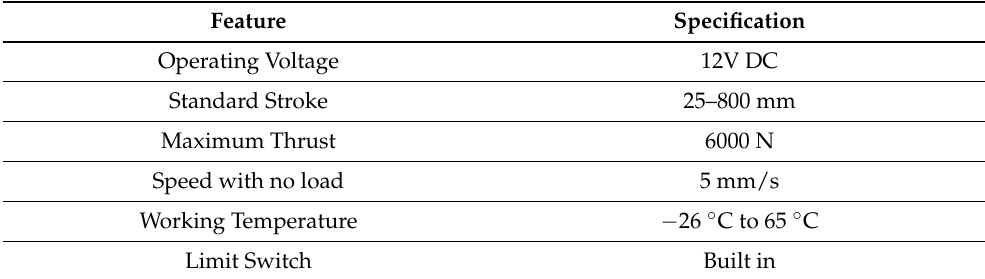
Table 2. Specifications of hydraulic